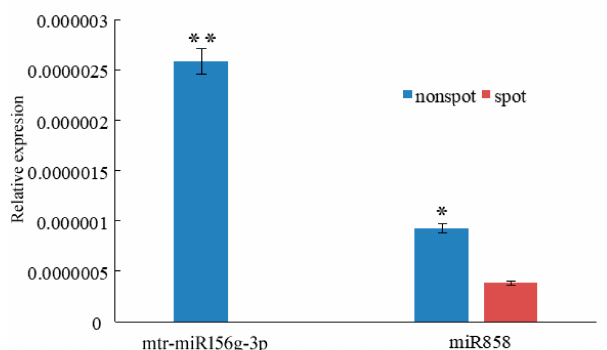
Figure 7. The expression level of mtr-miR156g-3p and miR858. ** represent an extremly significant di ff erence ( p < 0.01); * represent an significant di ff erence ( p <